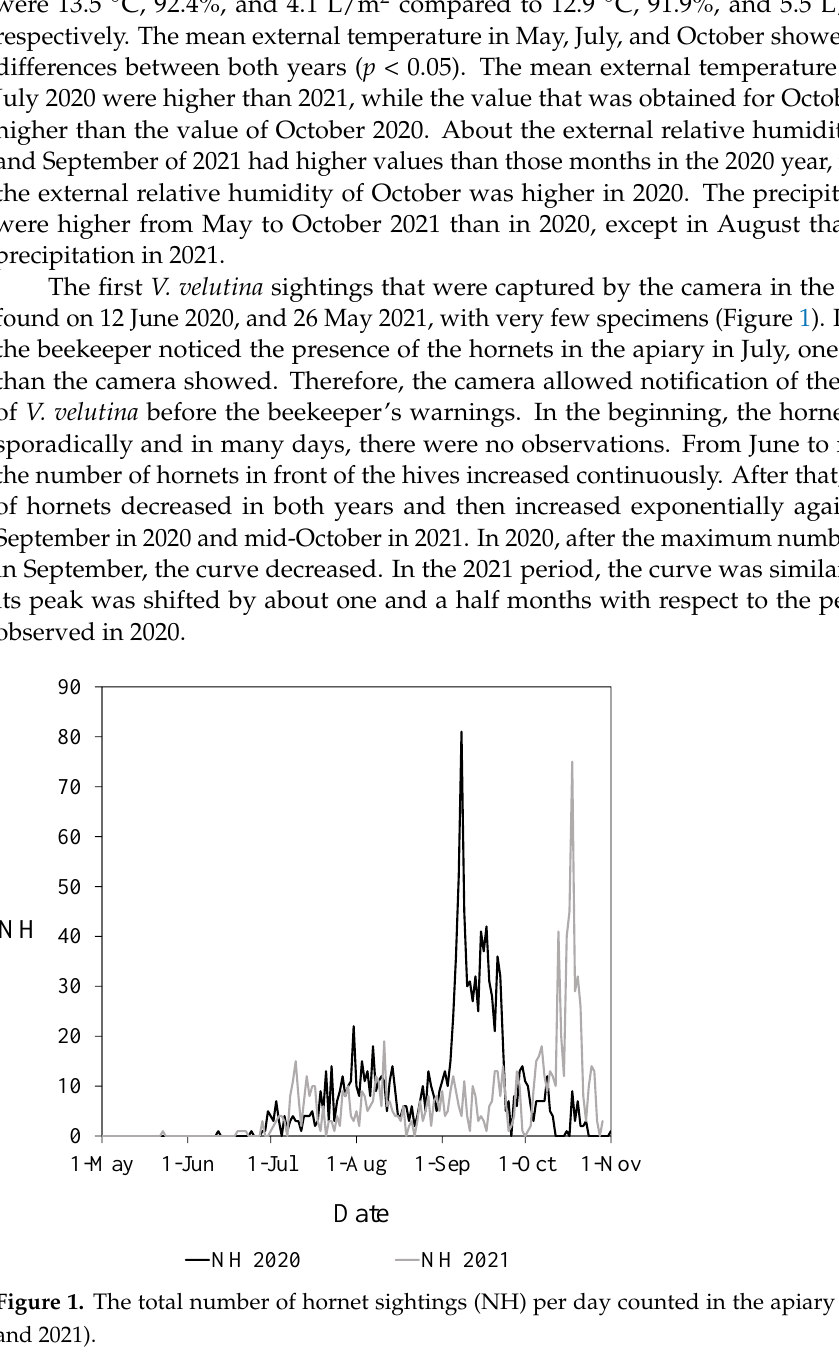
Figure 2. Relationship between the number of hornets (NH) that were found in front of the hives and the external parameters in both years, 2020 and 2021. ( a ): temperature (°C), ( b ): relative hu- midity (%). Correlations were performed to understand the relationship between the hornet pressure and the meteorological parameters in the period when hornets were present in the apiary. There was a positive correlation between hornet sightings and the external temperature ( r = 0.368, p < 0.01). Whereas inverse correlations were displayed between the hornets’ sighting and the external relative humidity ( r = −0 .347, p < 0.01). As the pat- tern of hornets’ pressure was different each month; the correlations were also diff erent depending on the month that was studied. The months of July and August had a lower correlation between the external temperature and V. velutina sightings as a result of the